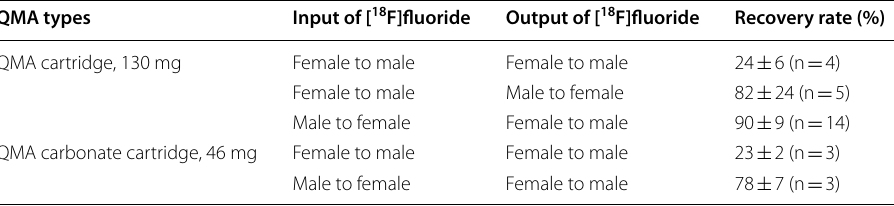
Table 1 Recovery of [ 18 F]Fluoride from QMA cartridge under various conditions in manual